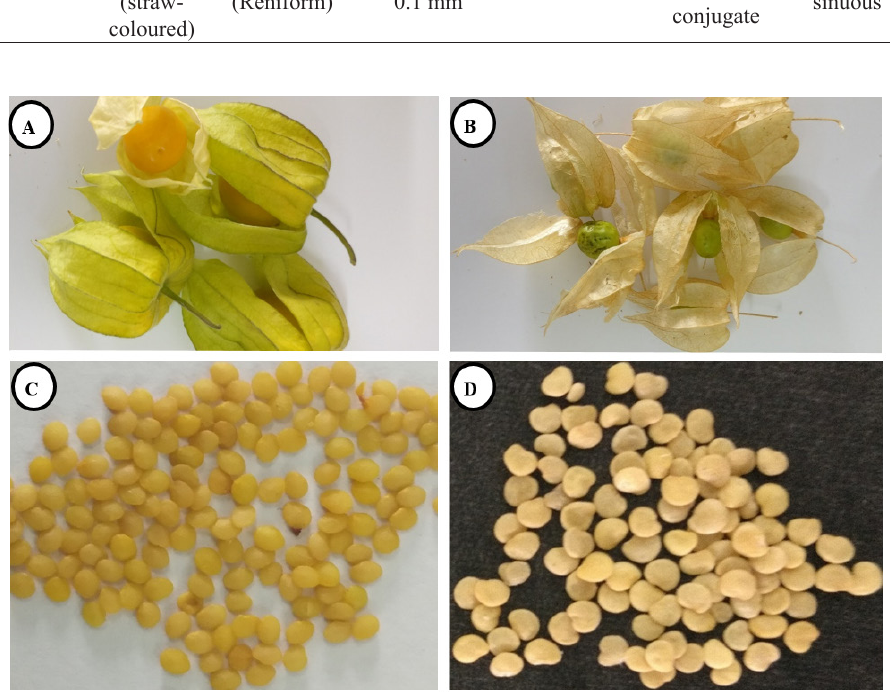
Figure 1: Fruits of Physalis species: (A) P. peruviana fruits (2750×1547); (B) P. pruinosa fruits (2671×1502) (C) P. peruviana seeds (1347×1192) and (D) P. pruinosa seeds